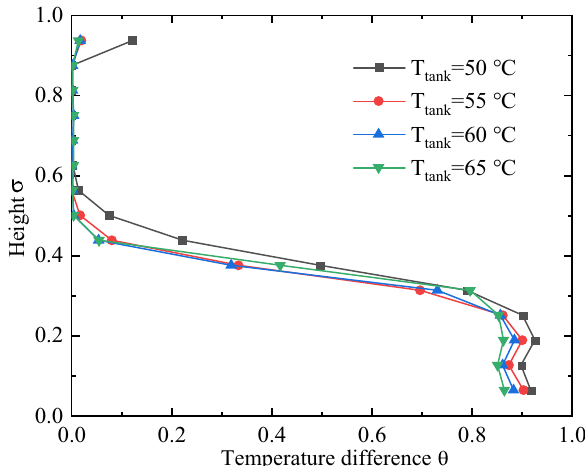
Fig. 18 Temperature changes of L1 when Re is 1975 and Fo is 0.9 in forward flow